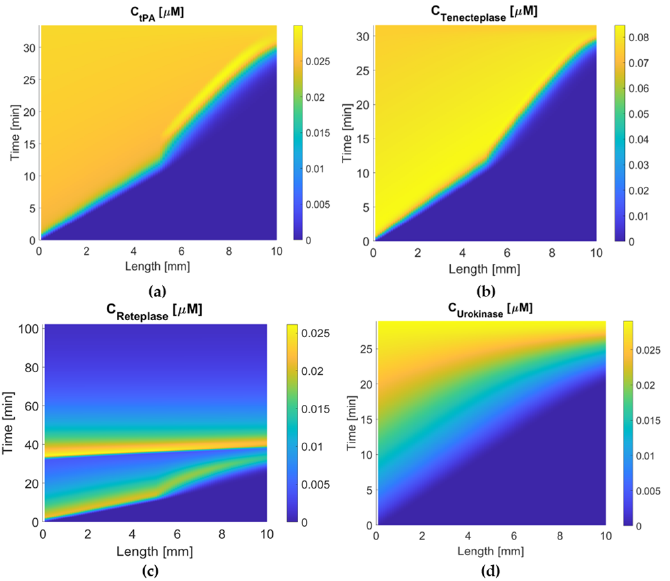
Figure 4. Temporal and spatial concentration profiles for ( a ) alteplase, ( b ) tenecteplase, ( c ) reteplase, and ( d ) urokinase in the clot. Lysis time: urokinase (26 min) < tenecteplase (30 min) ≈ alteplase (30 min) < reteplase (100 min).